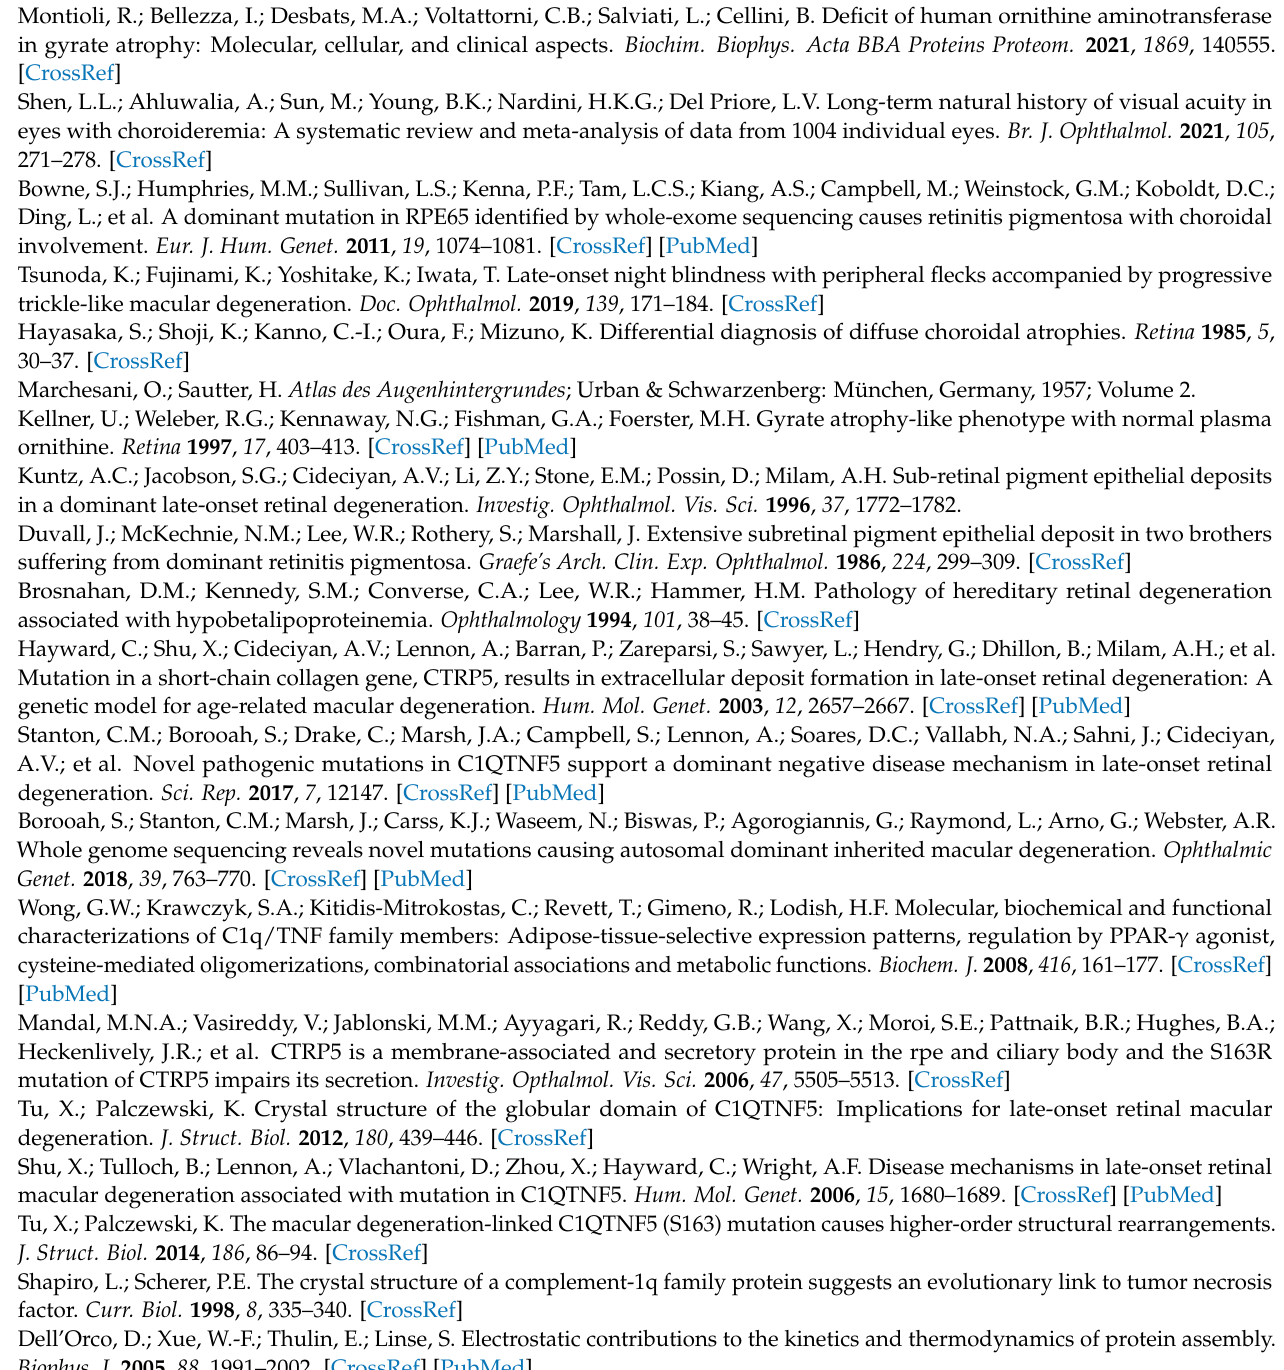
red colored bars. ( B ) Extended haplotype analysis using informative genotype data of 41 SNPs spanning a physical region of 2 Mb interval surrounding C1QTNF5 . Note that SNP genotypes were deduced from whole genome sequencing data that was only available for individuals III:2 and IV:2 from family BD 35, and for individuals IV:1 and IV:3 from family ADRP 386, respectively. The shared haplotype of the p.(Q180E) variant is indicated by red colored bars. Genomic coordinates refer to GRCh37/hg19. Ref, reference